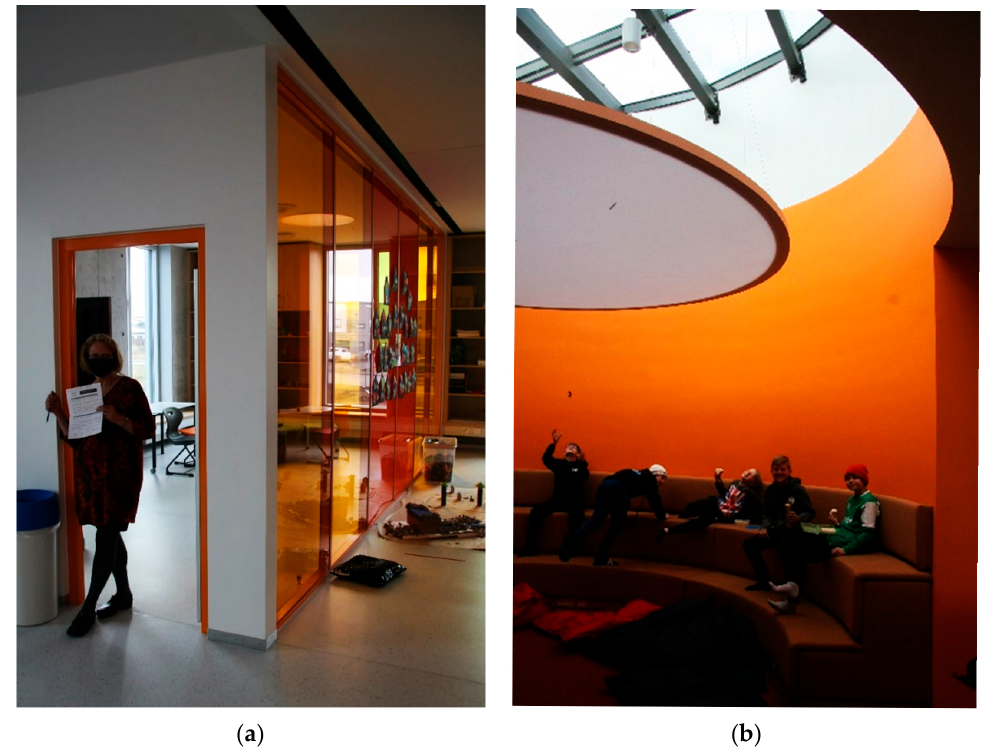
Figure 4. A classroom or tvennd. ( a ) One of two larger breakout rooms in a tvennd . ( b ) The oval core residing in the middle of the classroom.